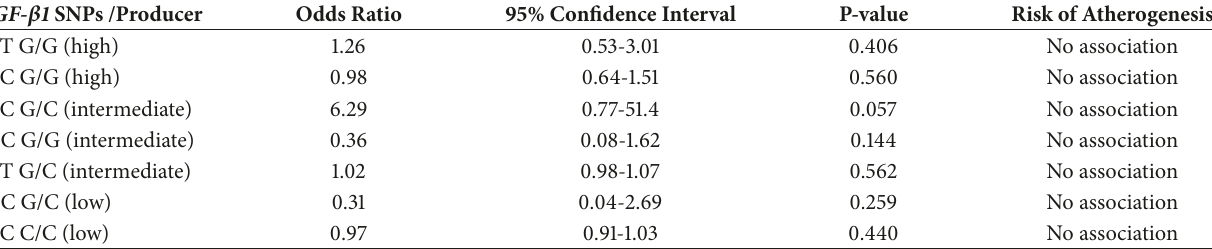
Table 7: Relationship between TGF- 𝛽 1 gene polymorphisms (T-869C and G-915C) and atherogenesis in CKD